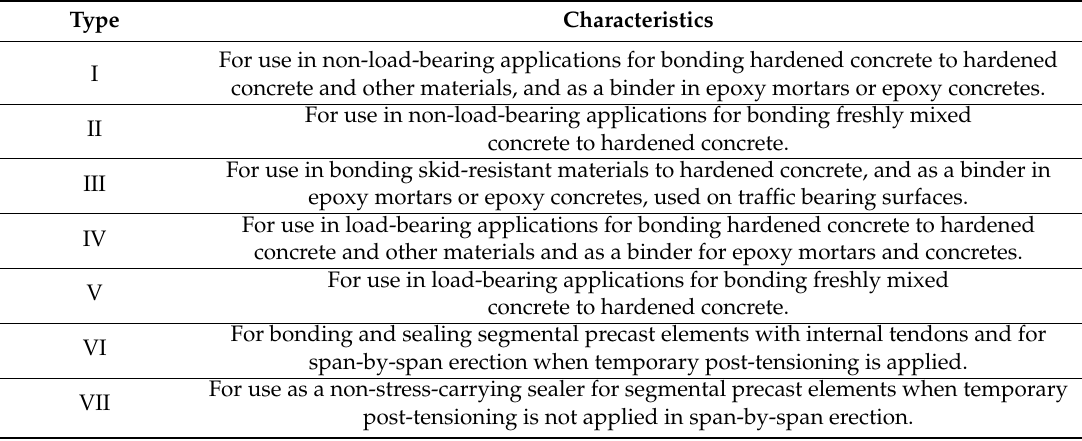
Table 1. Type of epoxy for bonding (ASTM C 881).